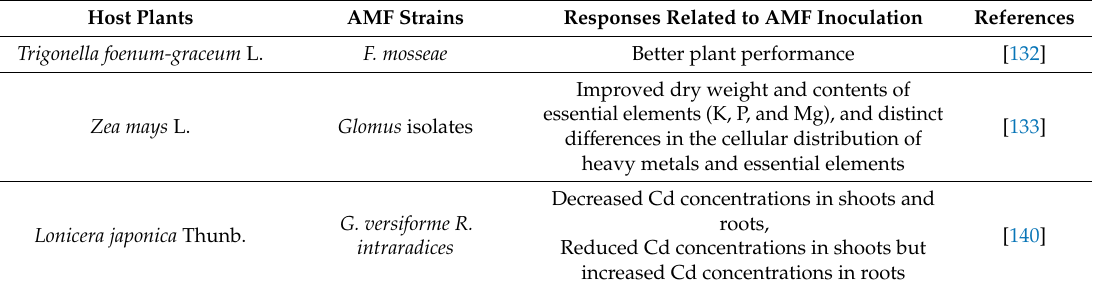
Table 5. Contribution of AMF in helping plants to cope with heavy metals